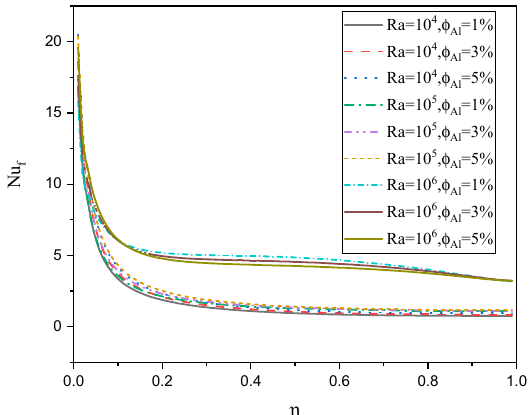
Figure 9. Profiles of the Nu f for the variation of the Rayleigh number and nanoparticle volume fraction φ Al = φ Cu at Ha = 15, H = 0.1, γ = π /6, Φ = π